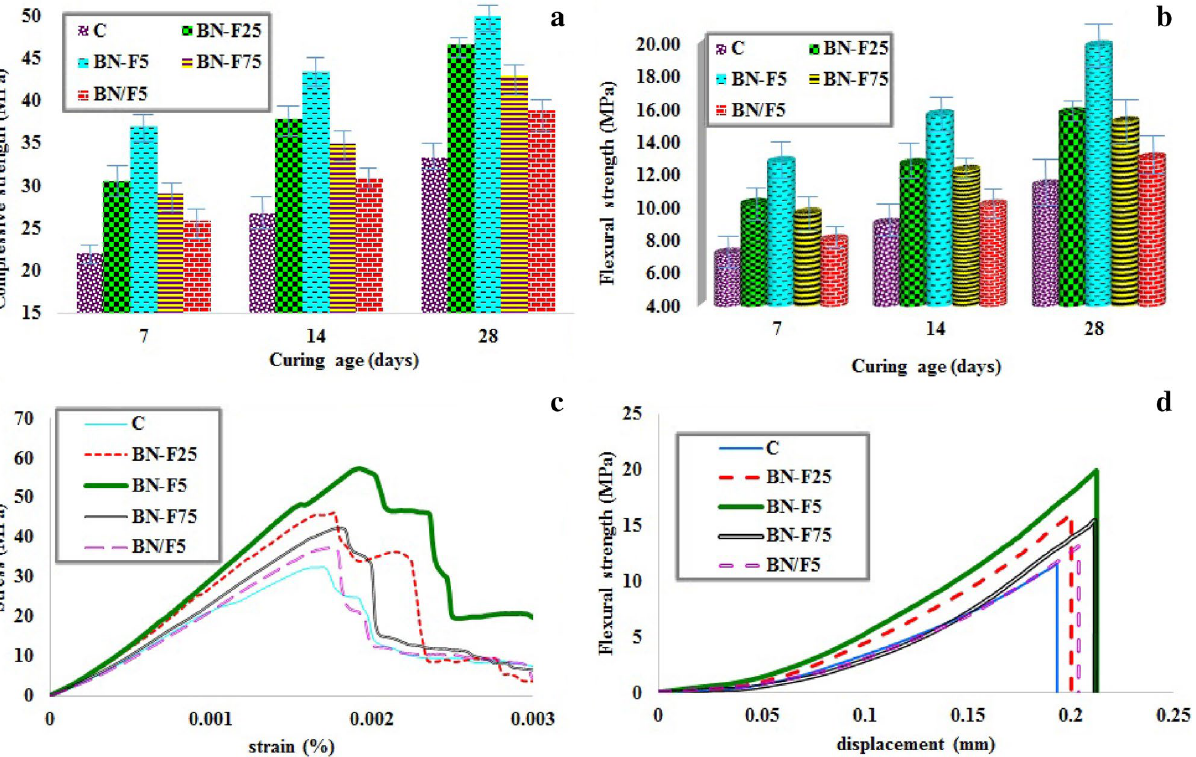
Figure 3. Compressive strength ( a ) and flexural strength ( b ) at different ages of hydration, compressive stress– strain diagrams ( c ) and flexural stress-displacement diagram ( d ) at 28 days of hydration of the cement paste samples containing different amounts of BN–Fe 3 O 4